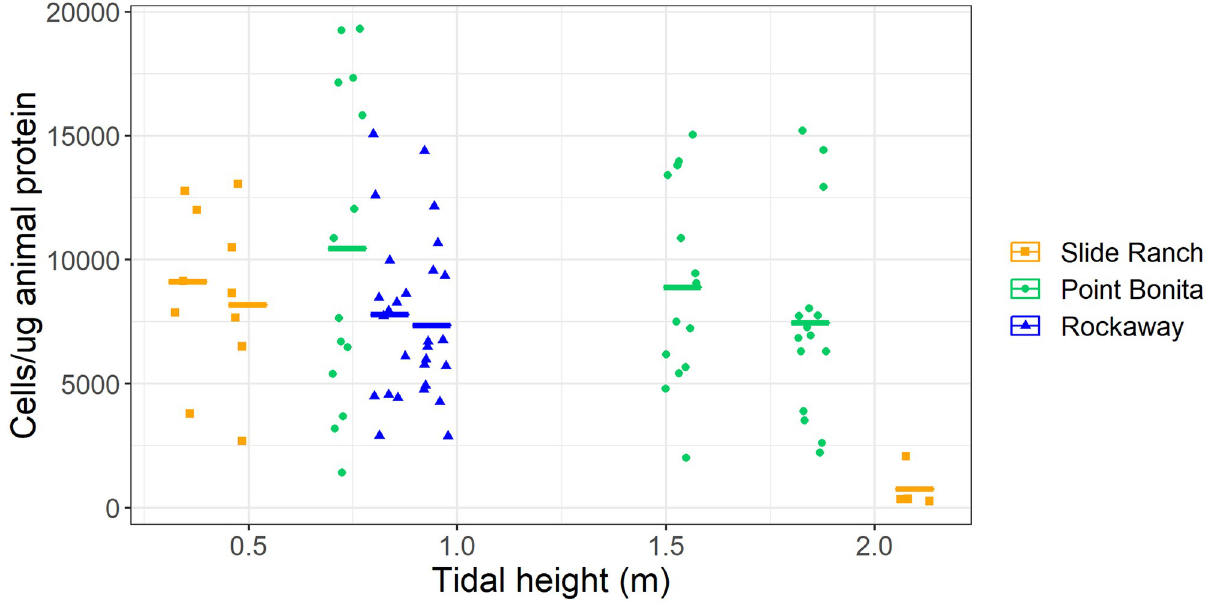
Fig 4. Symbiont abundance values across all surveyed pools. Individual anemones sampled for symbiont abundance are represented as dots, shown with increasing tidal height. Bars show the mean at each tidal height sampled. Mean symbiont density decreases as tidal height increases when looking at individual sites, but the pattern is less pronounced when all sites are grouped together.